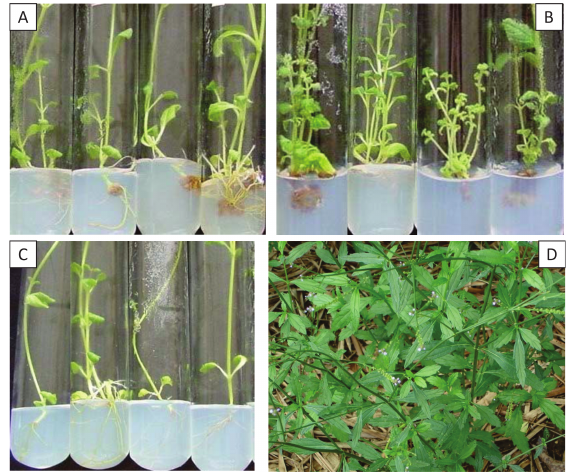
Fig. 1 - ( A and B ) Multiple rooting and shooting responses of Verbena litoralis nodal segments, 45 d after in vitro culture.